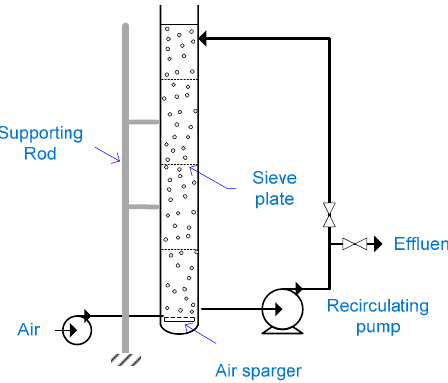
Figure 7. Schematic drawing of non ‐ concentrating slurry bubble column reactor.